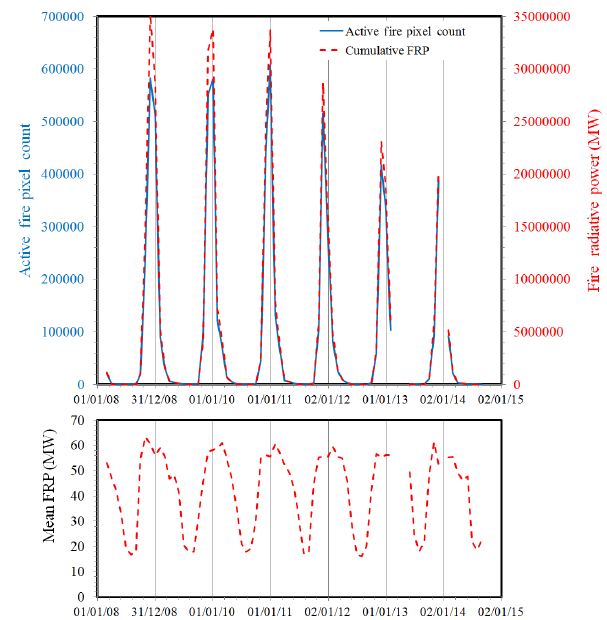
Figure 21. Metrics of monthly fire activity (total monthly FRP, monthly active fire pixel count, and the mean per-pixel FRP) for the Central African Republic, as extracted from the 2008–2014 time series of FRP-PIXEL products available from the LSA SAF